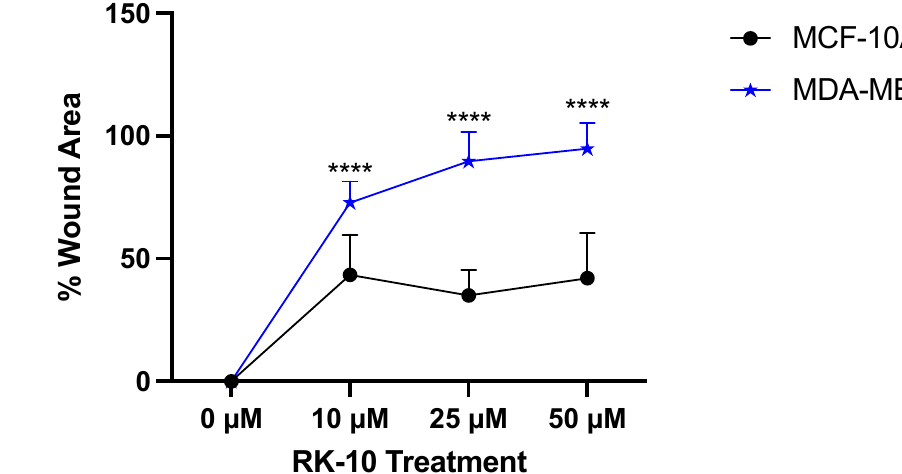
Figure 5. RK-10 attenuates wound healing. MCF-10A and MDA-MB 231 cells were treated with RK-10 and migration was measured using the wound healing assay. The wound distance was measured after 24 h and the graph represents the percentage of the wound area. Student’s t -tests were performed and treatments were compared to the DMSO control. Results are expressed as the means ± SDs (**** p < 0.0001), and data are representative, from one of at least three independent experiments.